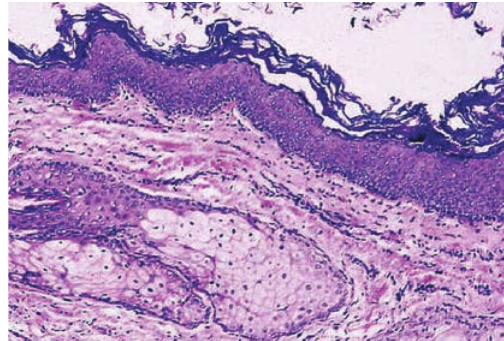
Figure 6: Cyst with keratinized squamous epithelium and adnexal structures in wall.